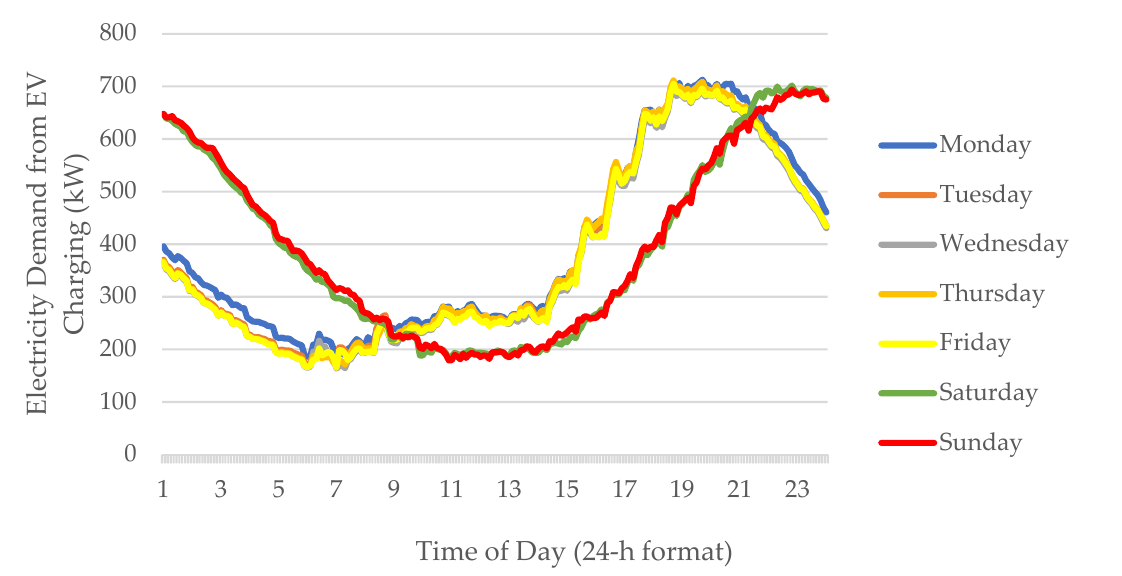
Figure 3. Daily comparison of hourly EV charging demand.